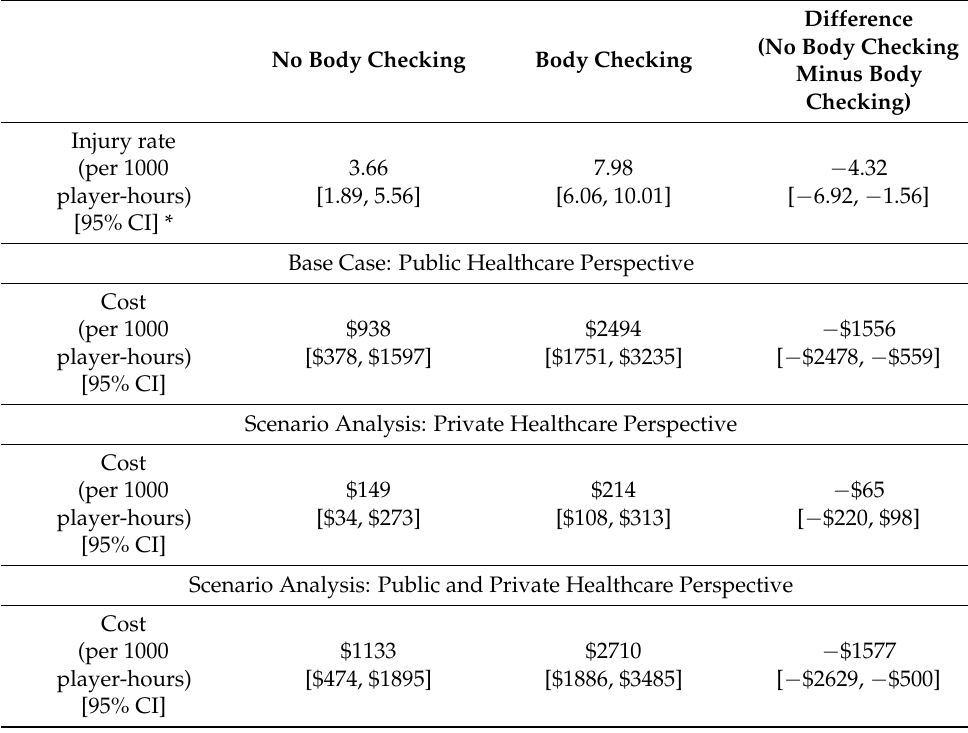
Table 5. Cost-effectiveness analysis results: injury rates and public and private healthcare costs.